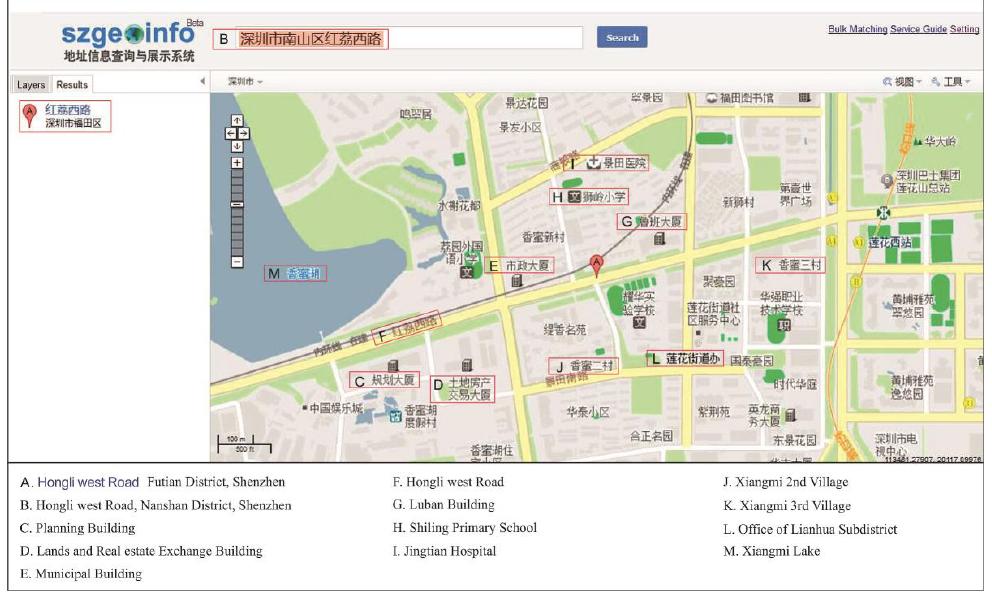
Figure 10. The online geocoding display system (accurate matching).